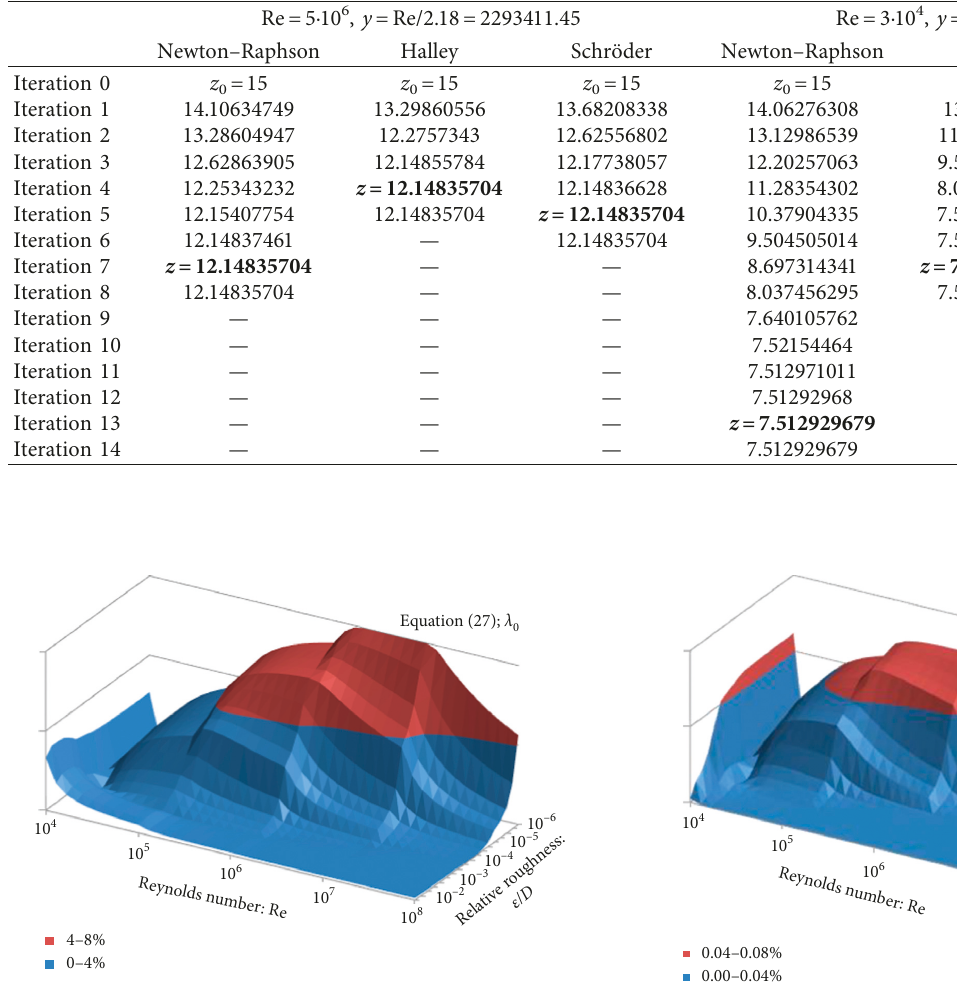
Figure 6: Distribution of the relative error over the domain of applicability of the Colebrook equation of the approximation, Equation (27); for i 0, the maximal relative error is 8.29%. (cid:31)